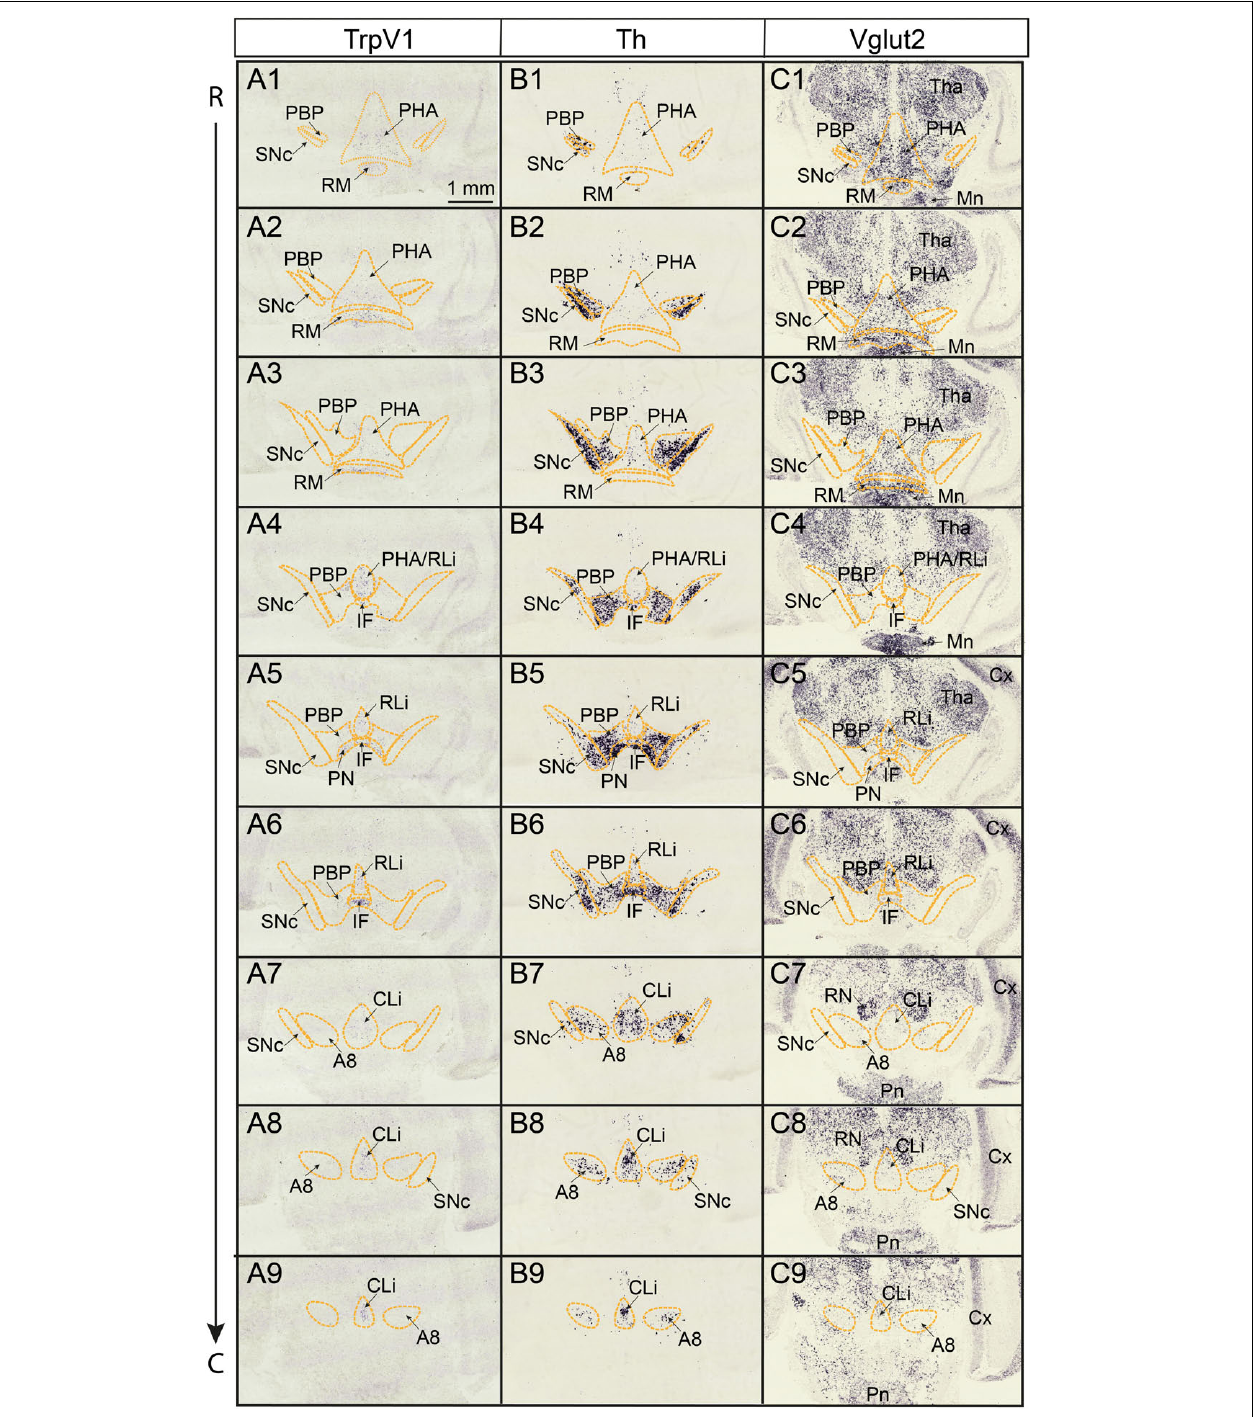
FIGURE 1 | TrpV1 mRNA is detected in scattered medial cells in a continuous manner reaching from the posterior hypothalamus rostrally throughout the VTA caudally. TrpV1, Th, Vglut2 mRNAs analyzed by colorimetric in situ hybridization (CISH) in serial coronal brain sections at postnatal day (P) 3. The rostral end of series at the levels of PHA, RM, and PBP; the caudal end of series at the level of CLi, A8. (A1–A9) TrpV1; (B1–B9) Th; (C1–C9) Vglut2. Scale bar; 1 mm. A8, A8 dopamine area; CLi, caudal linear nucleus; Cx, cerebral cortex; IF, interfascicular nucleus; Mn, mammillary nucleus; PBP parabrachial pigmented nucleus; PHA posterior hypothalamic nucleus; RLi, rostral linear nucleus; Pn, pontine nucleus; PN, paranigral nucleus; RM, retromammillary nucleus; RN, red nucleus; SNc, substantia nigra pars compacta ; VTA, ventral tegmental area; Tha, thalamus; R, rostral; C, caudal.